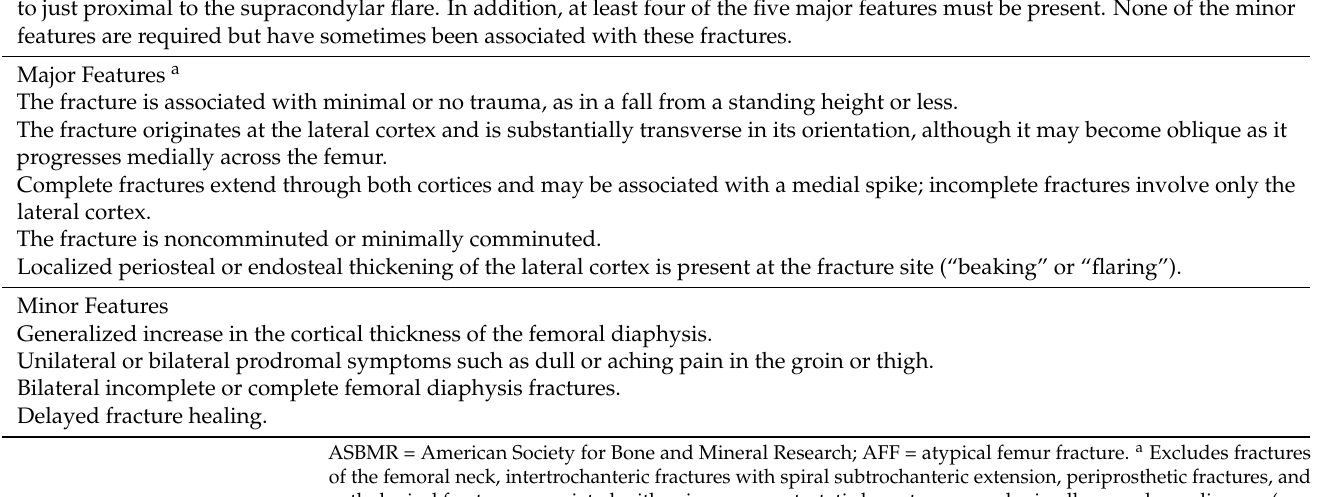
Table 3. ASBMR task force 2013 revised case definition of